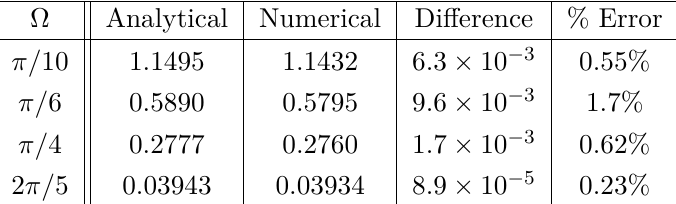
Table 1. log 2 (cid:15) coefficient for different opening angles Ω . The numerical values were computed by curve fitting the area of the surface described in section